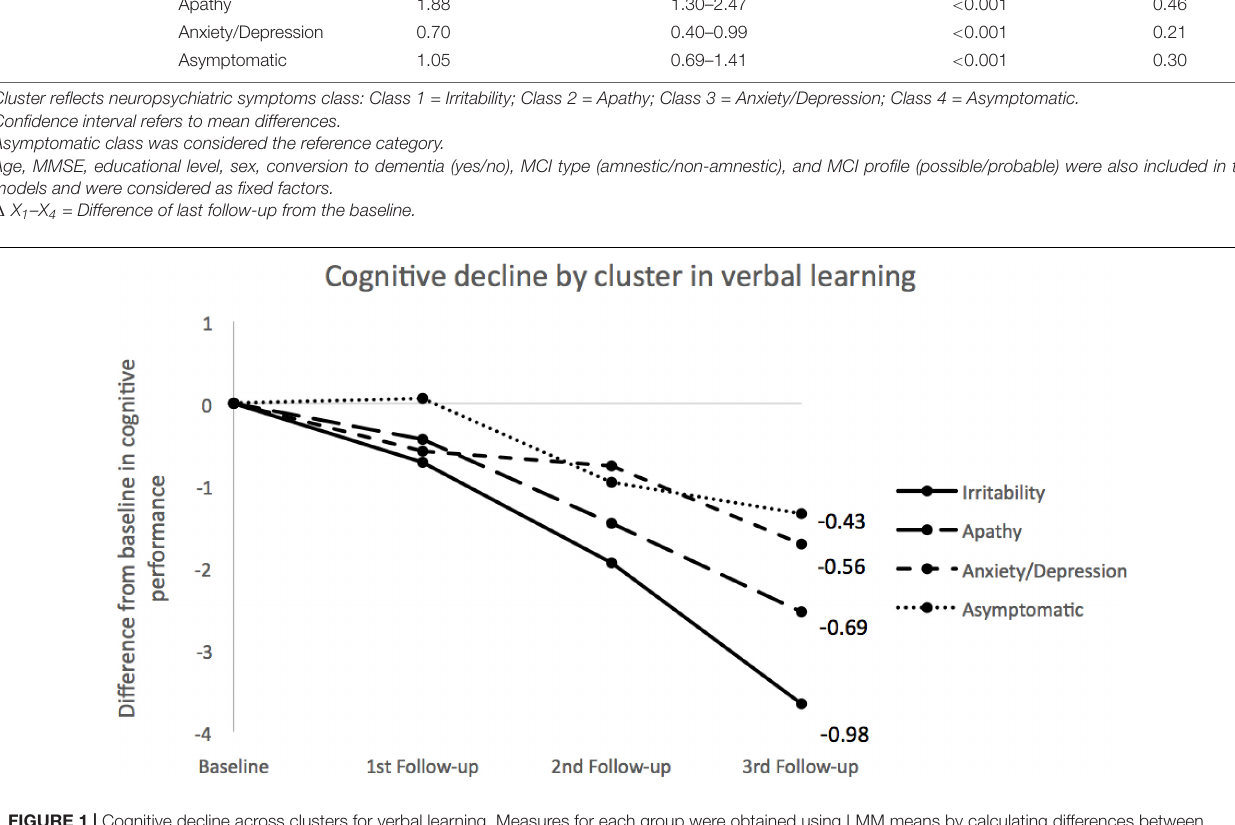
of cognitive worsening in MCI patients, especially those with an amnestic